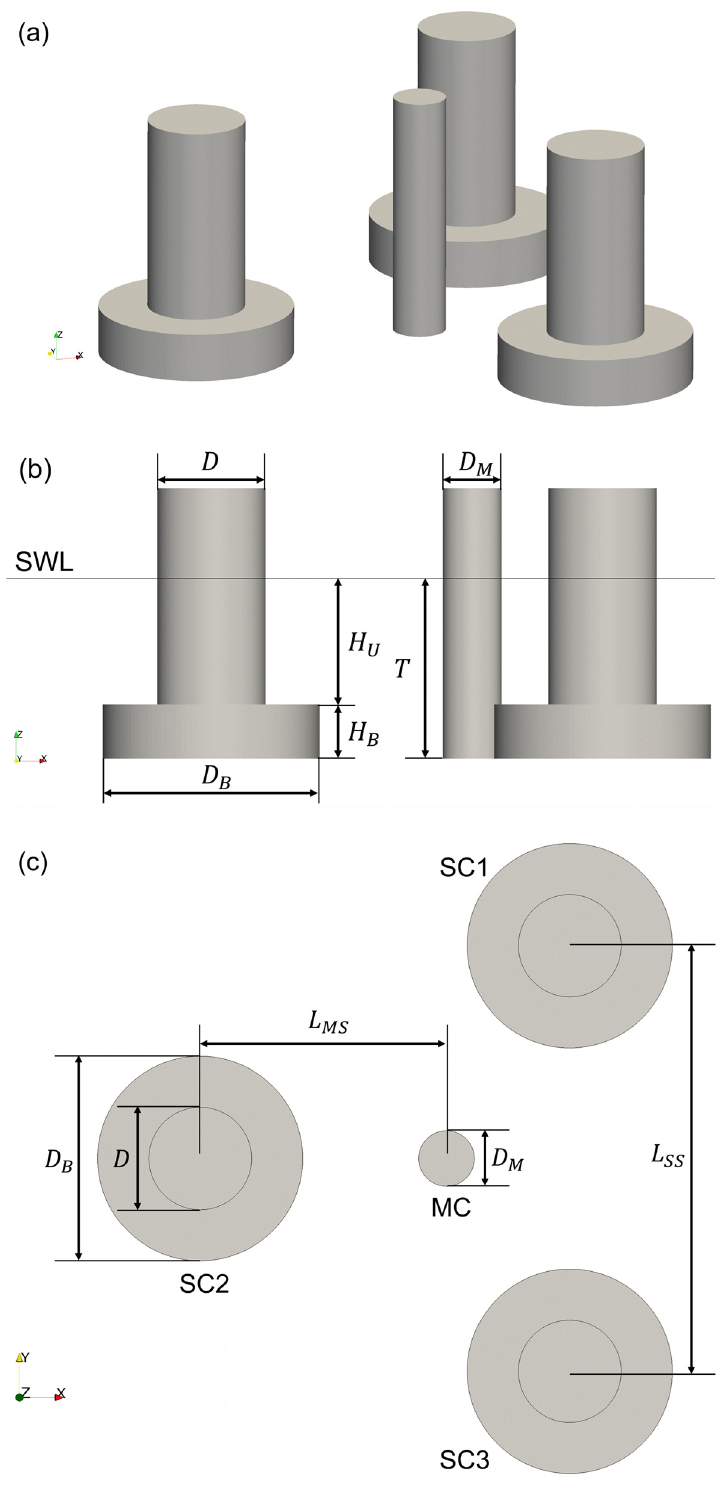
Figure 1. Geometry definition of FOWT platform: ( a ) 3D view; ( b ) side view; and ( c ) top view.